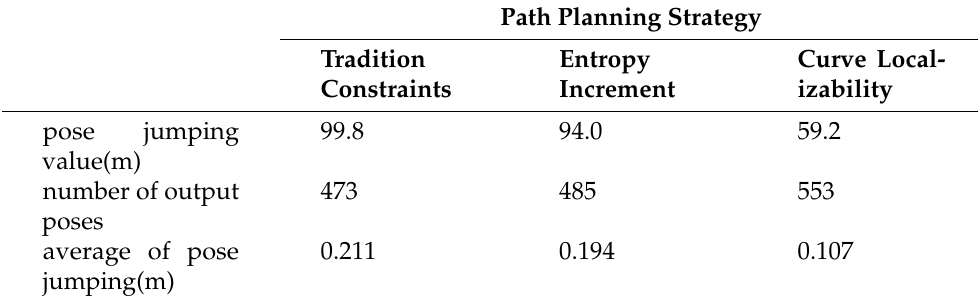
Table 1. Results of different path planning